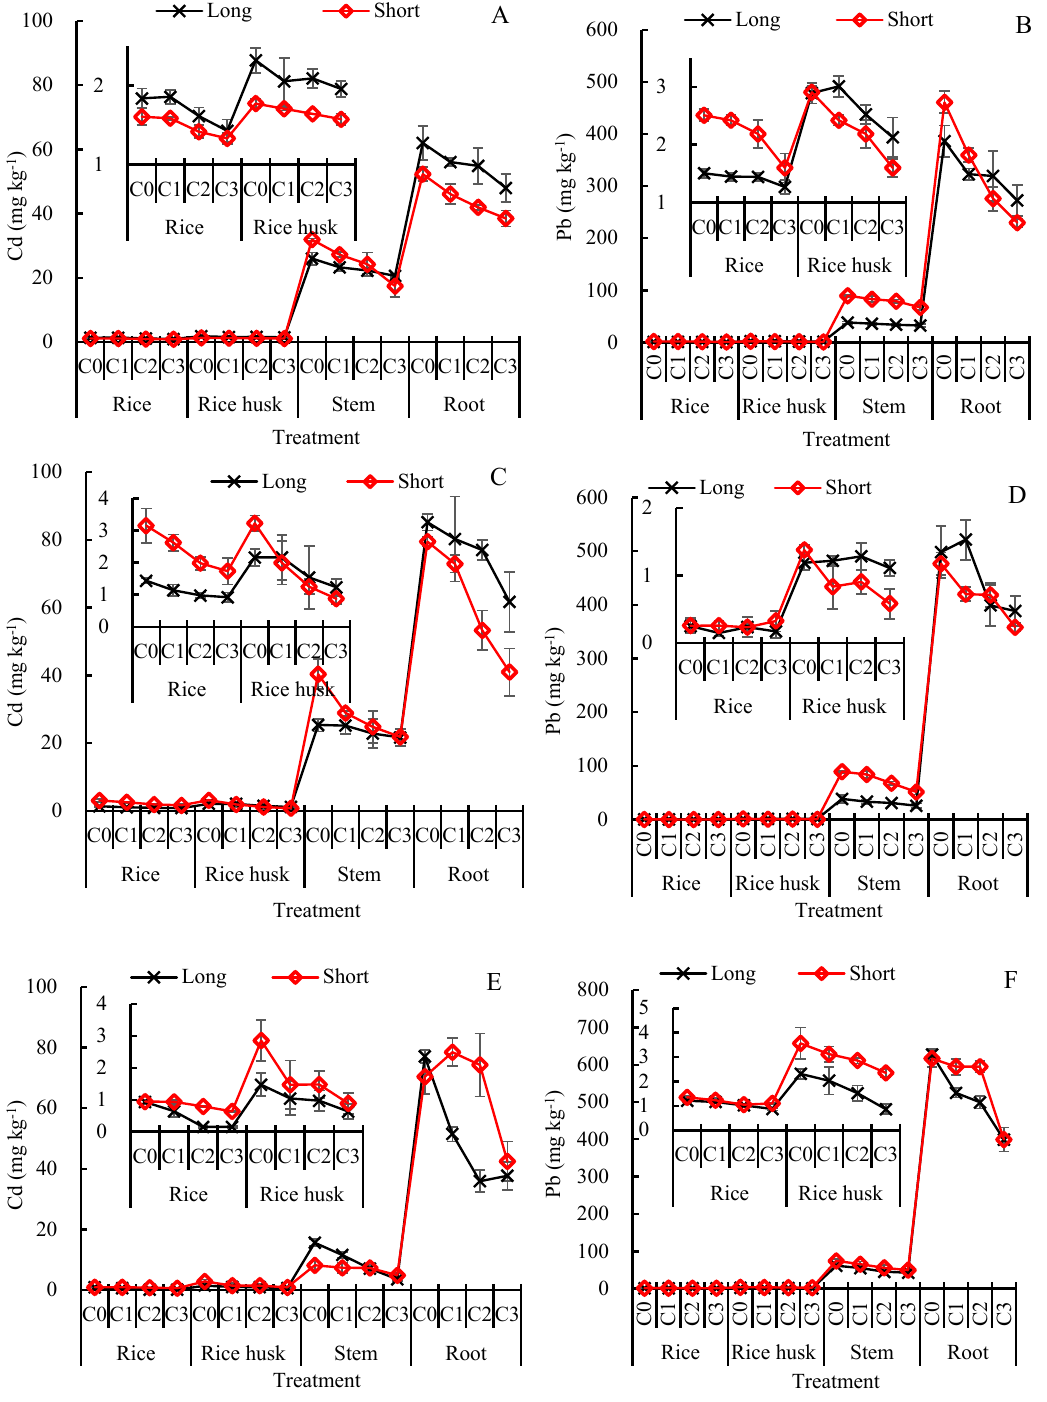
Figure 3. The effect of long- and short-term, increasing biochar application rates [0 (C0), 10 (C1), 20 (C2) and 40 (C3) t ha − 1 ] on Cd and Pb distribution in rice over time (( A ): 2016 Cd; ( B ): 2016 Pb; ( C ): 2017 Cd; ( D ): 2017 Pb; ( E ): 2018 Cd; ( F ): 2018 Pb; Long: long-term; Short: short-term). Error bars represent standard deviation of the mean ( n = 3).